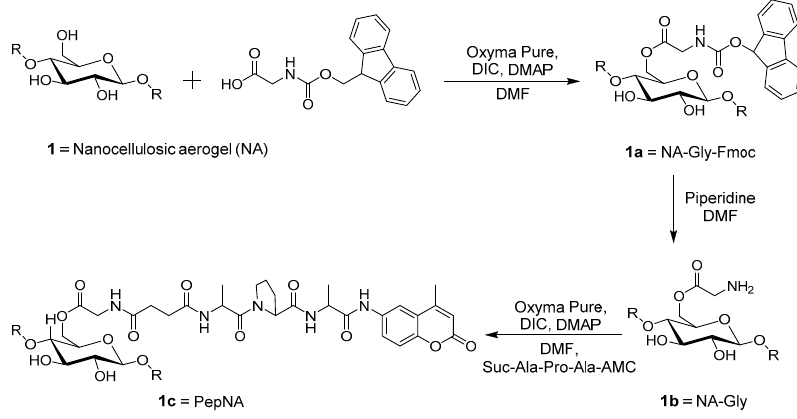
Figure 2. Scheme of cellulose esterification with glycine followed by tripeptide (Suc-Ala-Pro-Ala-4-amino-7-methyl-coumarin (AMC)) conjugation to the nanocellulosic aerogel. Note NA and PepNA are defined as nanocellulosic aerogel and peptide nanocellulosic aerogel, respectively. DIC, diisopropylcarbodiimide.